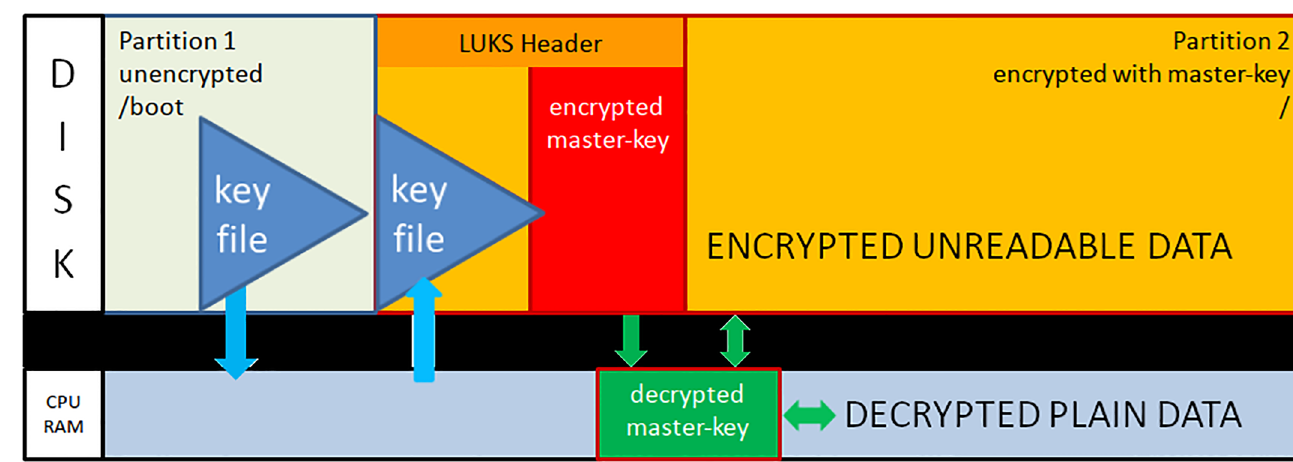
Fig 3. Operational system state with transparent data de- and encryption.